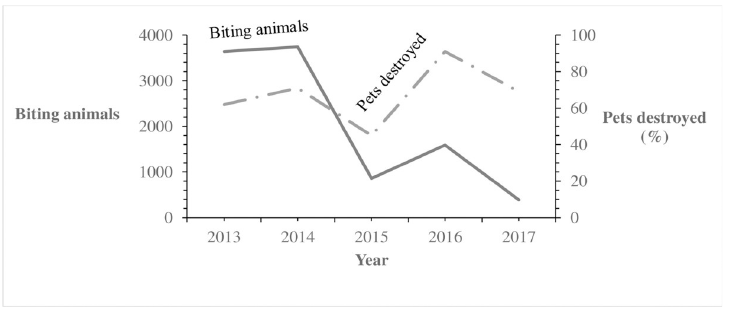
Fig 4. Reported trends of pets destroyed (%) among biting animals in Uganda: 2013–2017. The Solid line represents biting animals. The Long Dash Dot line represents pets destroyed.